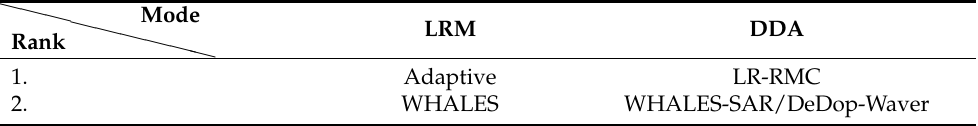
Table 6. Selection of the Sea State Climate Change Initiative (SeaState_cci) project management and production team. (Revision of original Table